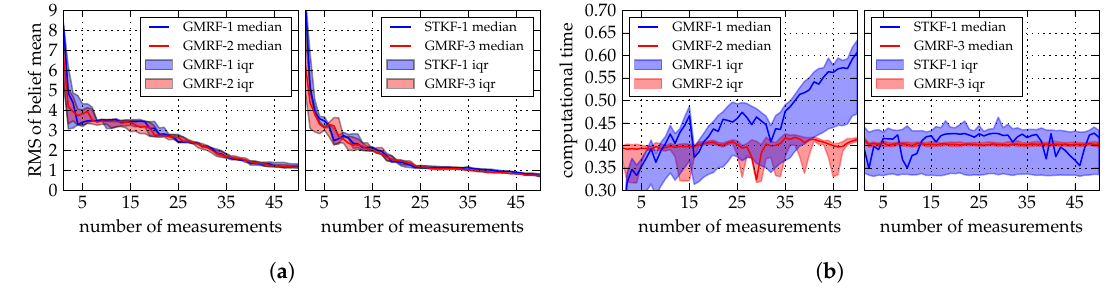
Figure 11. Belief model comparison. ( a ) Median and inter-quarter ranges of the root mean square of the belief algorithms’ predictive variance sum. ( b ) Medians and inter-quarter ranges of the belief algorithms’ computational time over fifty simulation runs.